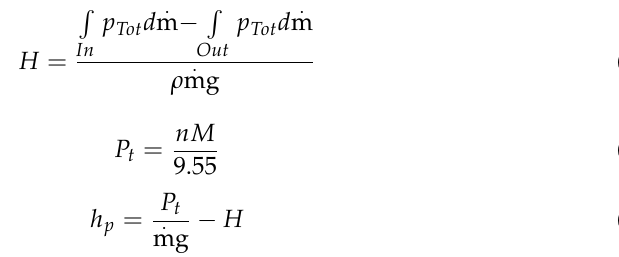
0.5 0.6 0.7 0.8 0.9 1.0 1.1 1.2 1.3